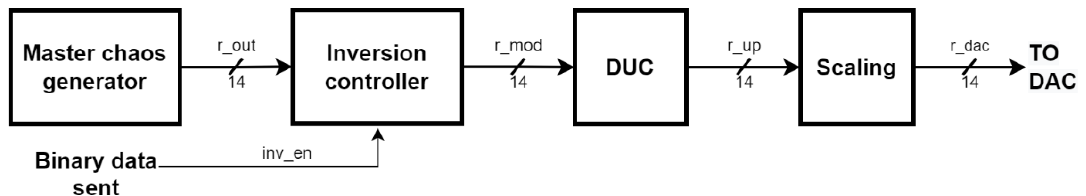
Figure 9. The general structure of the transmitter.